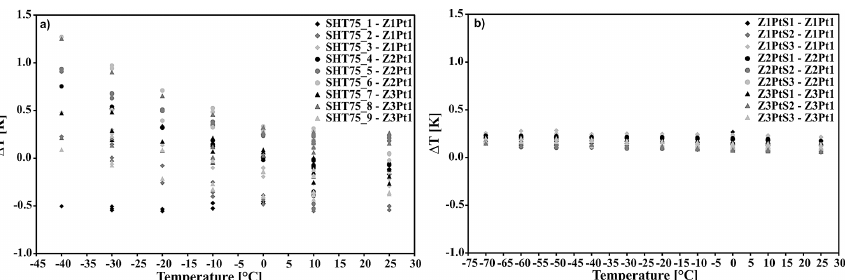
Figure 4. 1T of the measured values relative to the Pt100 in the middle of each measuring chamber. In (a) temperature is measured by the Pt100 glued onto SHT75, while in (b) temperature is measured by the SHT75